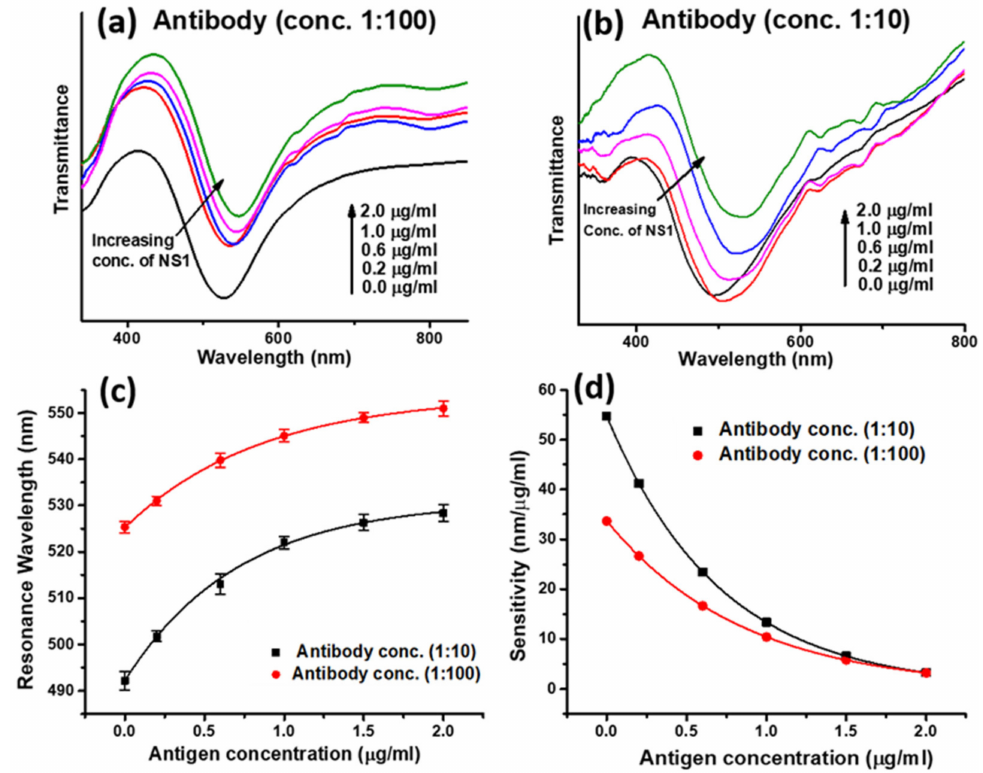
Figure 19. ( a ) SPR spectra with increasing concentration of NS1 antigen for antibody concentration ( a ) 1:100 and ( b ) 1:10 used in the fabrication of sensing recognition layer. Corresponding ( c ) calibration, and ( d ) sensitivity curves. Reprinted with permission from Ref. [101]. Copyright 2022